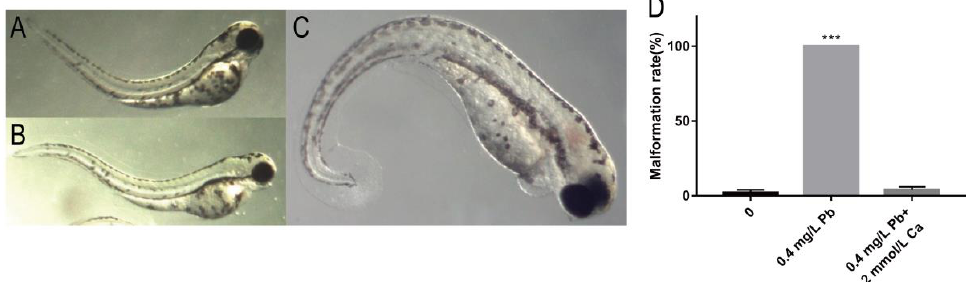
Figure 2. Spinal malformation in zebrafish embryos at different periods of 0.4 mg/L Pb 2+ exposure. ( A ) Bend upwards at 72 hpf; ( B ) S-shaped curved at 96 hpf; ( C ) Bend downward at 120 hpf; ( D ) Malformation rate at 120 hpf. (*** p < 0.001, n = 50, Repeat three times.) Table 1. Statistics of Pb 2+ (0.4 mg/L) on spinal curvature of zebrafish in different periods. Malformation 72 hpf 96 hpf 120 hpf upward curvature 52.0 ± 1.5% 0% 0% S-shaped curvature 0% 85.0 ± 2.5% 0% downward curvature 0% 0% 100% Total 52% 85% 100% n = 50, repeat three times.